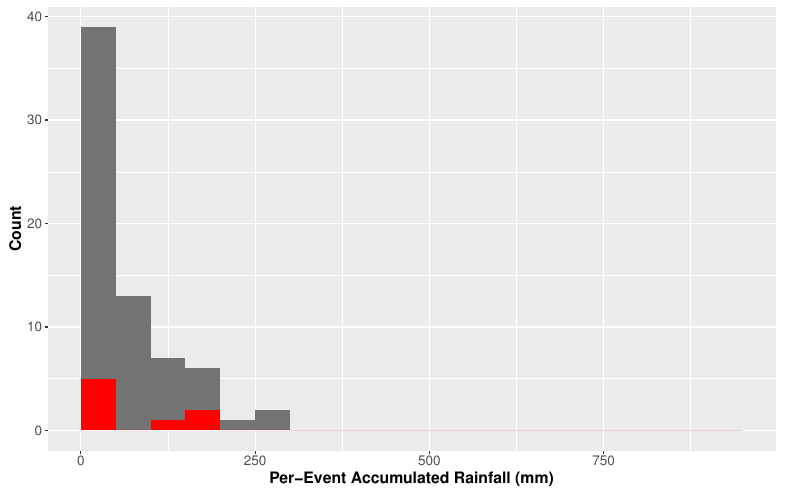
Figure 4. Histogram for tropical cyclone rainfall for Miami, Florida. Red bars indicate events post 2007. The duration that a TC remains over a location may affect the amount of rainfall in an